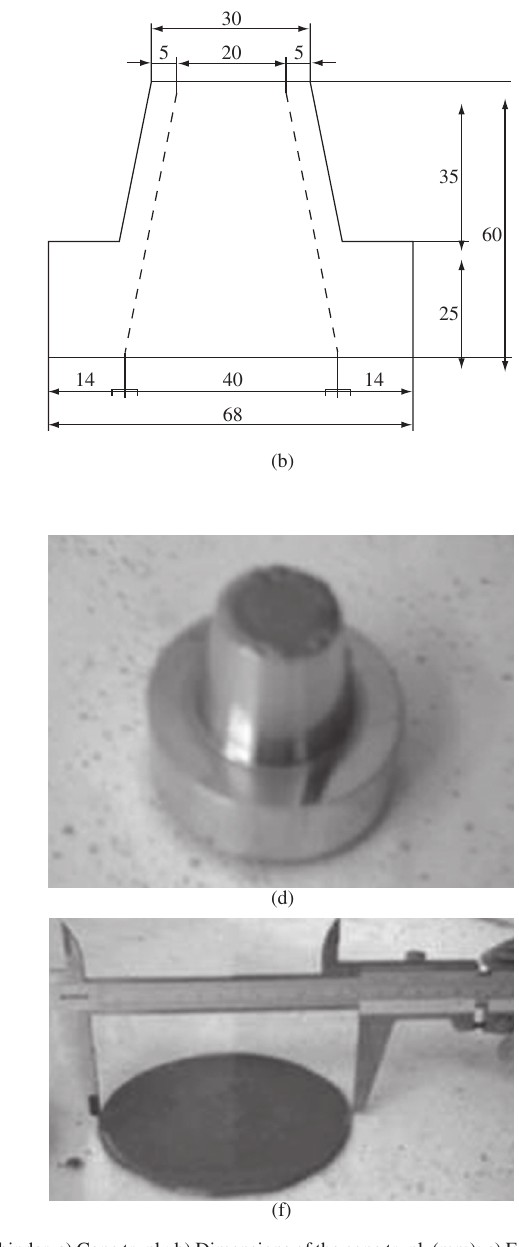
Figure 2. Verification of the superplasticizer additive potentiality in mixtures of binder. a) Cone trunk; b) Dimensions of the cone trunk (mm); c) Fulfilling with cement paste; d) Filled cone trunk; e) Scattering area of cement paste; and f) Measurement of the maximum diameter. Source: Liborio and Castro 8